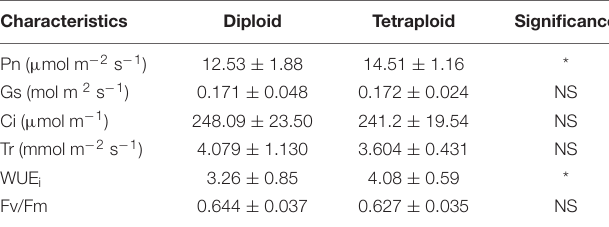
TABLE 5 | Leaf photosynthetic parameters of diploid and tetraploid Eucalyptus urophylla . Characteristics